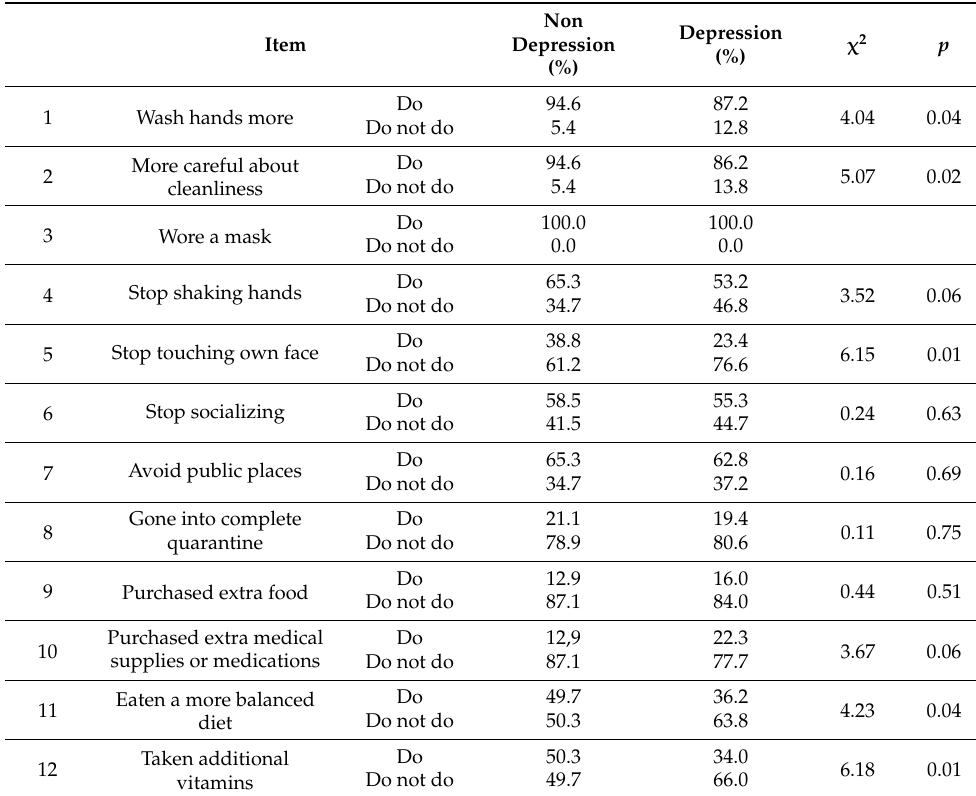
Table 3. Differences in behavioral changes between the two